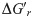
The top three pathways found by AGPathFinder in the search of glycolysis in KEGG when ψ(Sc,Td) = ψ(false,true) (these three pathways are represented by p1, p2 and p3 respectively).Round rectangles represent compound nodes, rectangles represent reaction edges, and the data in parentheses denote the value ΔG′r of reaction and compound similarity respectively.